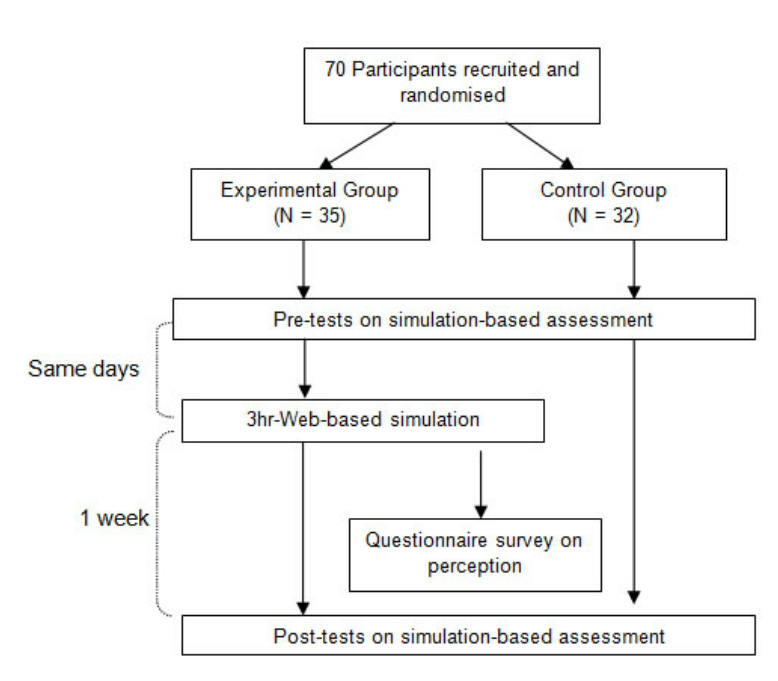
Figure 2. Flow of data